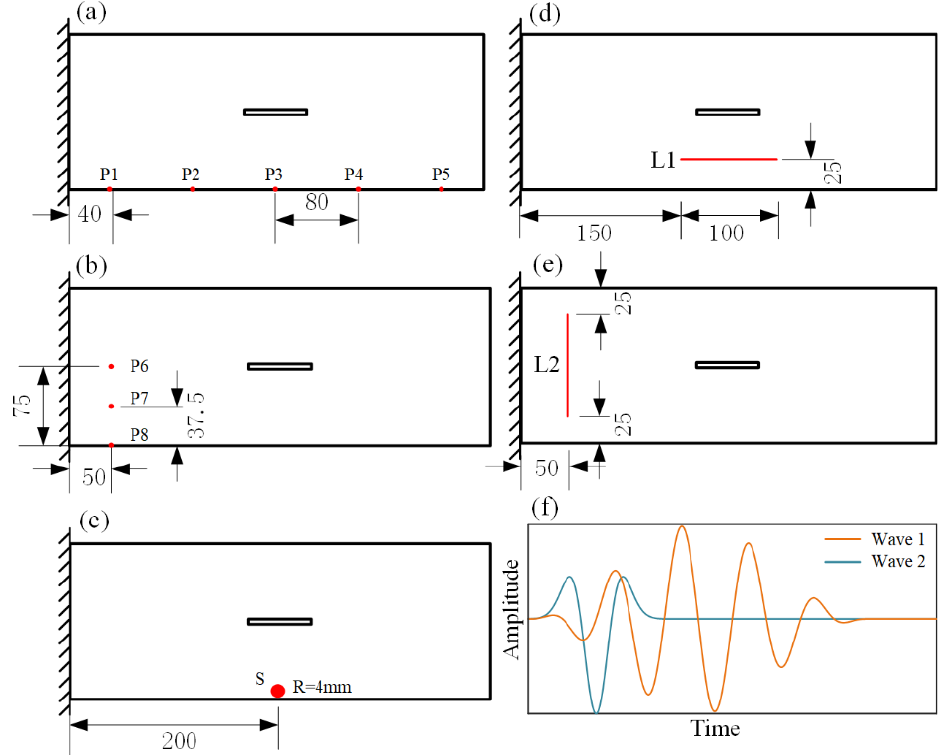
Figure 7. ( a ) Pointwise excitations at different horizontal locations. ( b ) Pointwise excitations at different vertical locations. ( c ) Surface excitation with a radius of R = 4 mm. ( d ) Horizonal line excitation. ( e ) Vertical line excitation. ( f ) Different temporal waveforms of excitations.